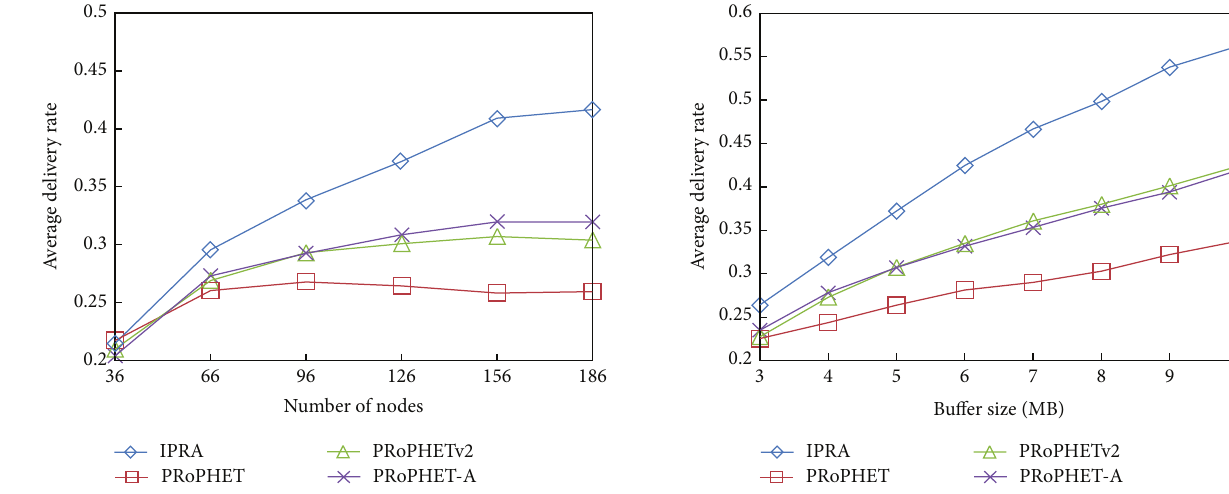
Figure 4: Average delivery rate (ADR) versus number of nodes.